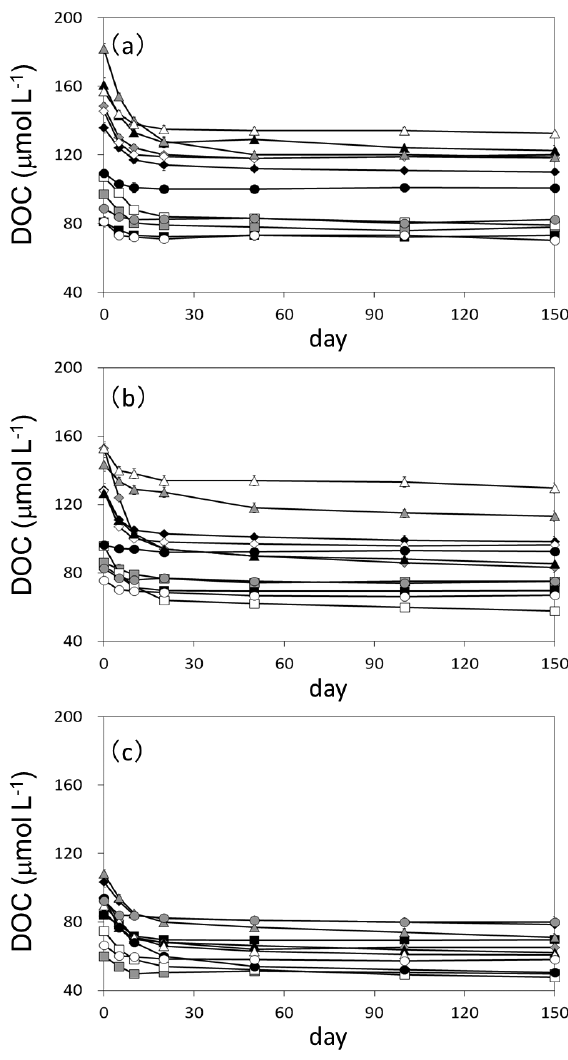
Figure 4. Changes in dissolved organic carbon (µmolL − 1 ) in the surface water of stations (a) F3, (b) F6, and (c) 06. Black square: January 2011; gray square: February 2011; white square: March 2011; black diamond: April 2011; gray diamond: May 2011; white diamond: June 2011; black triangle: July 2011; gray trian- gle: August 2011; white triangle: September 2011; black circle: October 2011; gray circle: November 2011; white circle: Decem- ber 2011. Error bars represent the standard deviations.